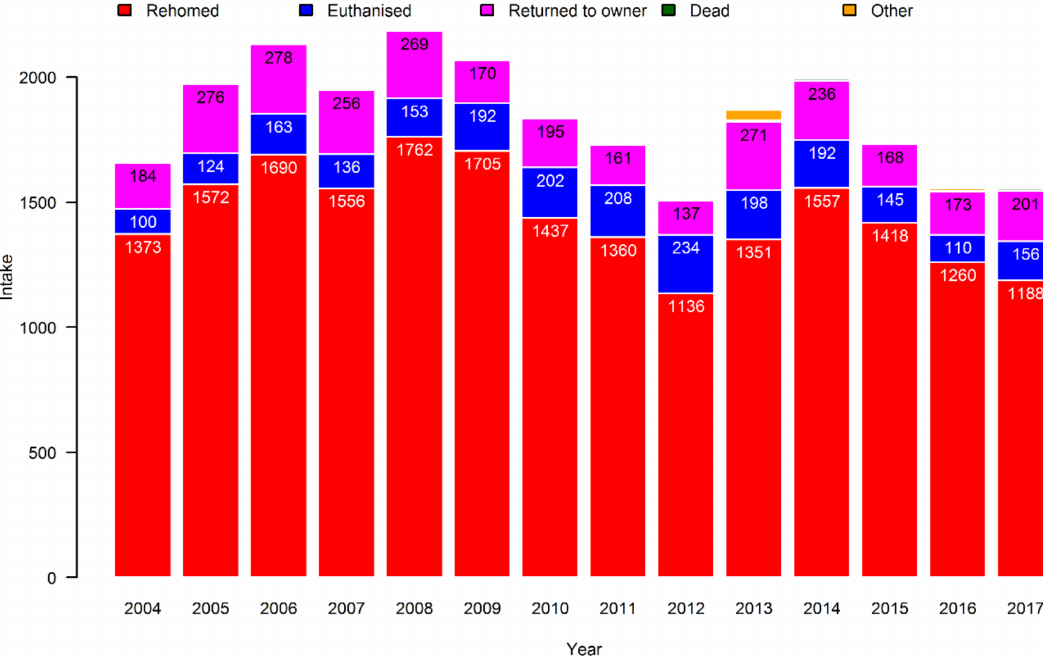
Figure 5. The final outcomes for dogs placed in Danish shelters from 2004 to 2017. The category “Dead” contained only three dogs, and is therefore barely